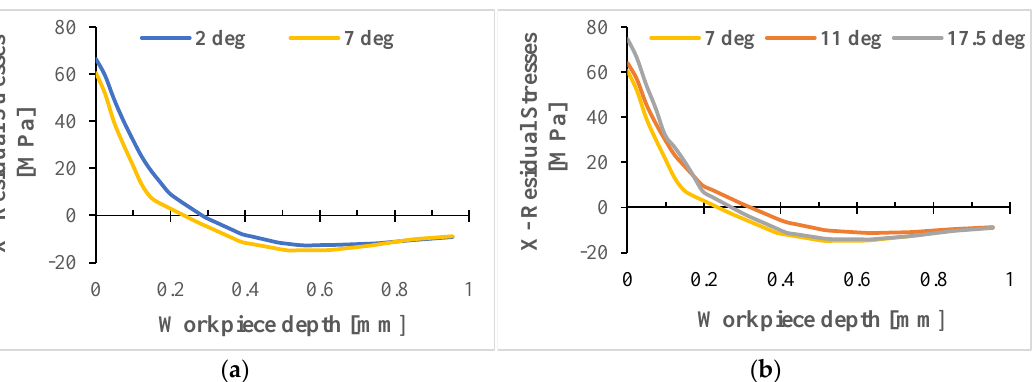
Figure 23. Effect of the clearance angle on the axial X-residual stresses (r ε = 20 µm). ( a ) 2–7°; ( b ) 7– 17.5°.